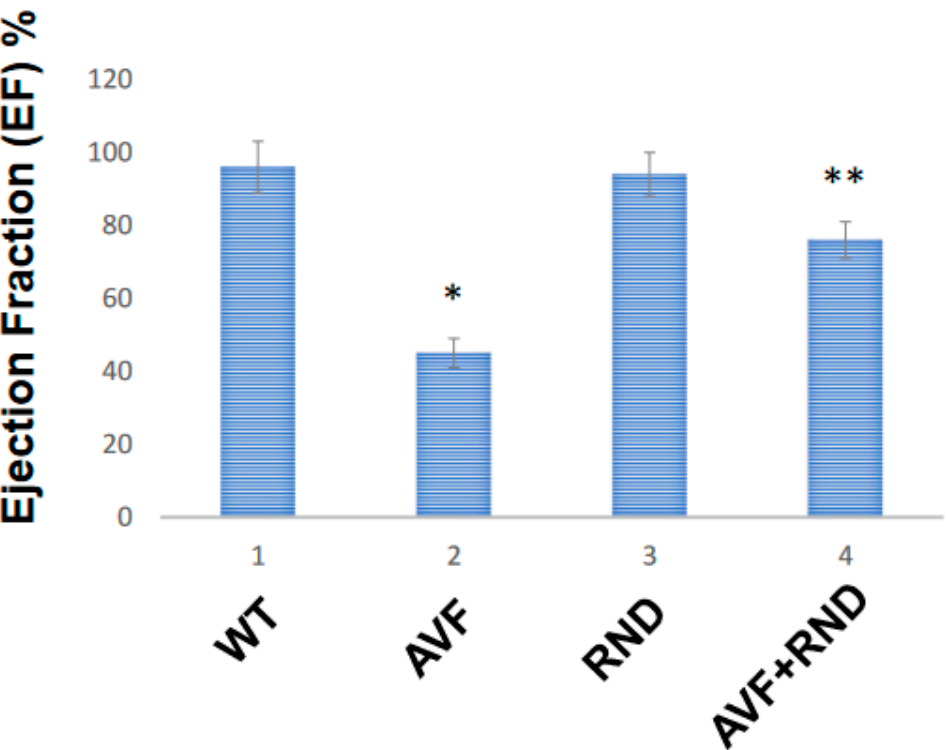
Figure 4. The cardiac ECHO data from C57BL/6J WT-control, AVF, RND, and AVF-RND male mice at 16 weeks. The bar graph represents percent (%) ejection fraction of the male mice hearts. The mean ± SD from n = 5; *, p < 0.05 compared to WT; **, p < 0.05 compared with AVF.